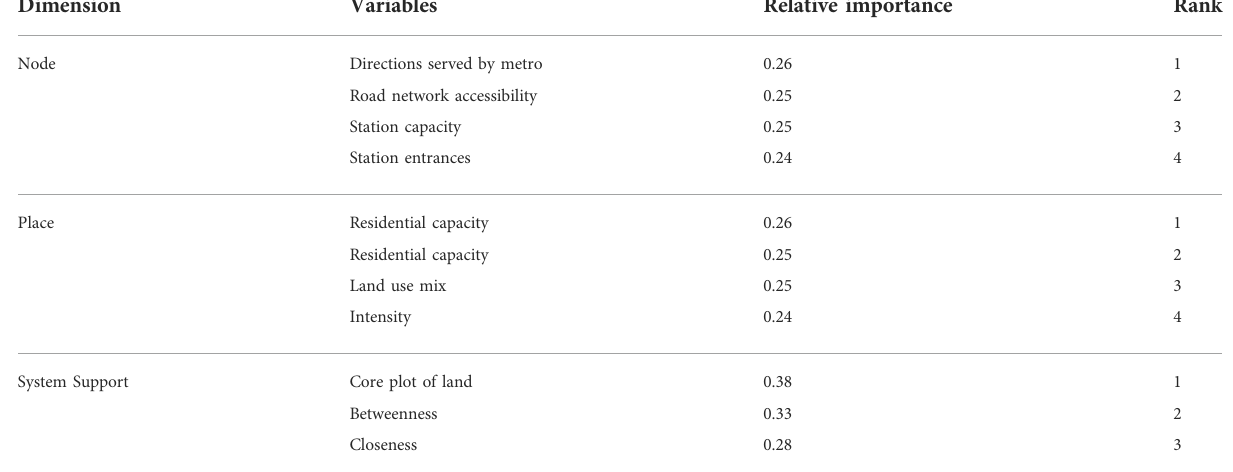
TABLE 4 The weight of each indicator.